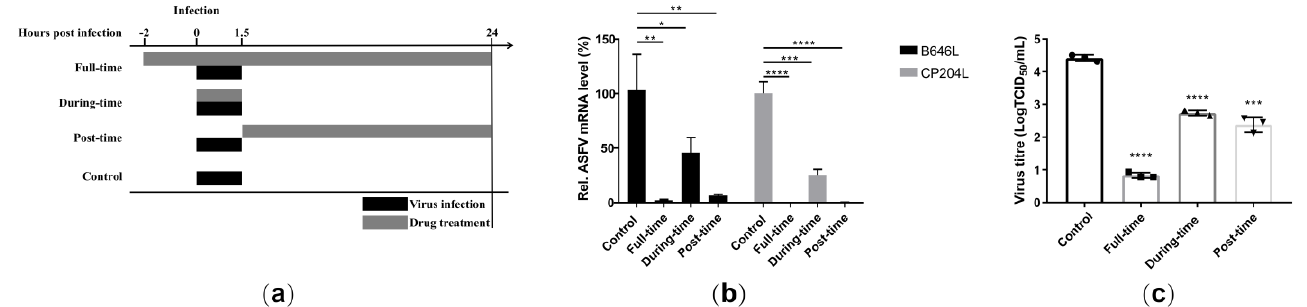
Figure 5. Time-of-addition analysis. ( a ) The schematic diagram of the time-of-addition; ( b ) the ASFV B646L and CP204L gene transcription levels in the different experimental groups was evaluated with an RT-qPCR; ( c ) the ASFV production in the different experimental group was evaluated with a TCID 50 assay. Each datum represents the results of three independent experiments (means ± SD). Significant differences compared with the control group are denoted with *, p < 0.05; **, p < 0.01; ***, p < 0.001; ****, p < 0.0001.